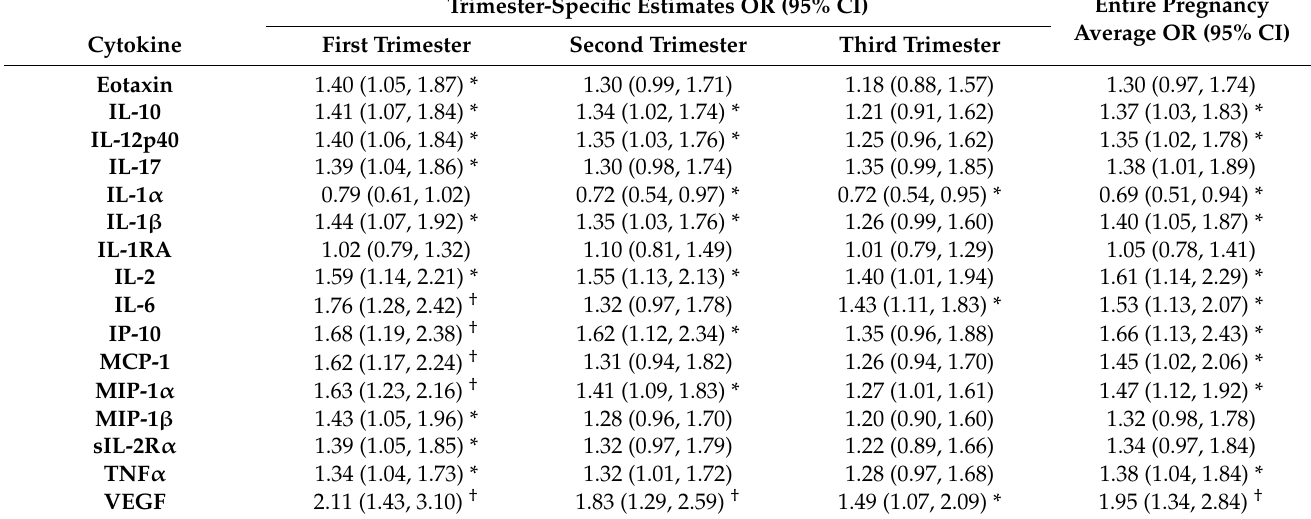
Table 3. Adjusted a odds ratios(OR) (95% confidence intervals) for preterm birth per log unit increase in cervico-vaginal cytokine concentrations (pg/mL) from models b including single trimester average, and entire pregnancy average, from the PRINCESA Cohort in Mexico City, 2009-14 (N =